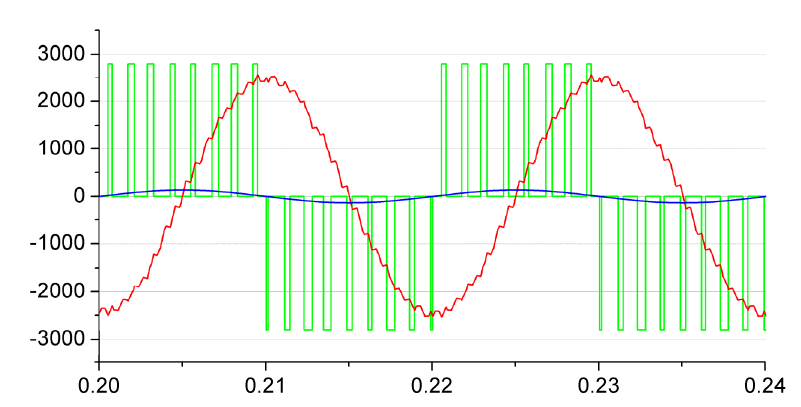
Figure 13. Simulation outputs of 3L-NPC inverter under LVRT operation (output voltage pulses-green, grid voltage-blue, phase current-red, V current, DC bus voltage VDC = 1.1